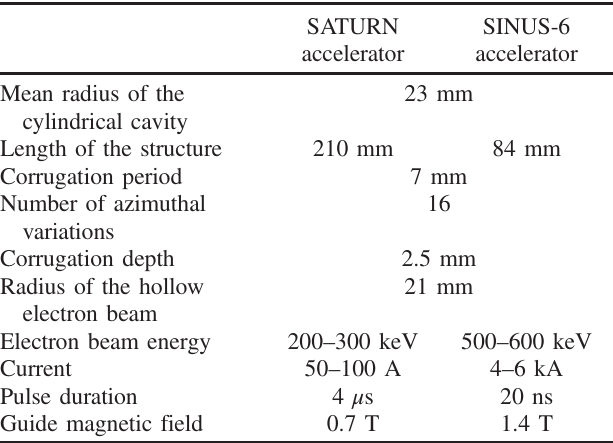
TABLE I. Basic parameters of Ka-band 2D SWOs realized on the thermionic-emission accelerator SATURN and design param- eters for the project based on the high-current explosive-emission accelerator SINUS-6.